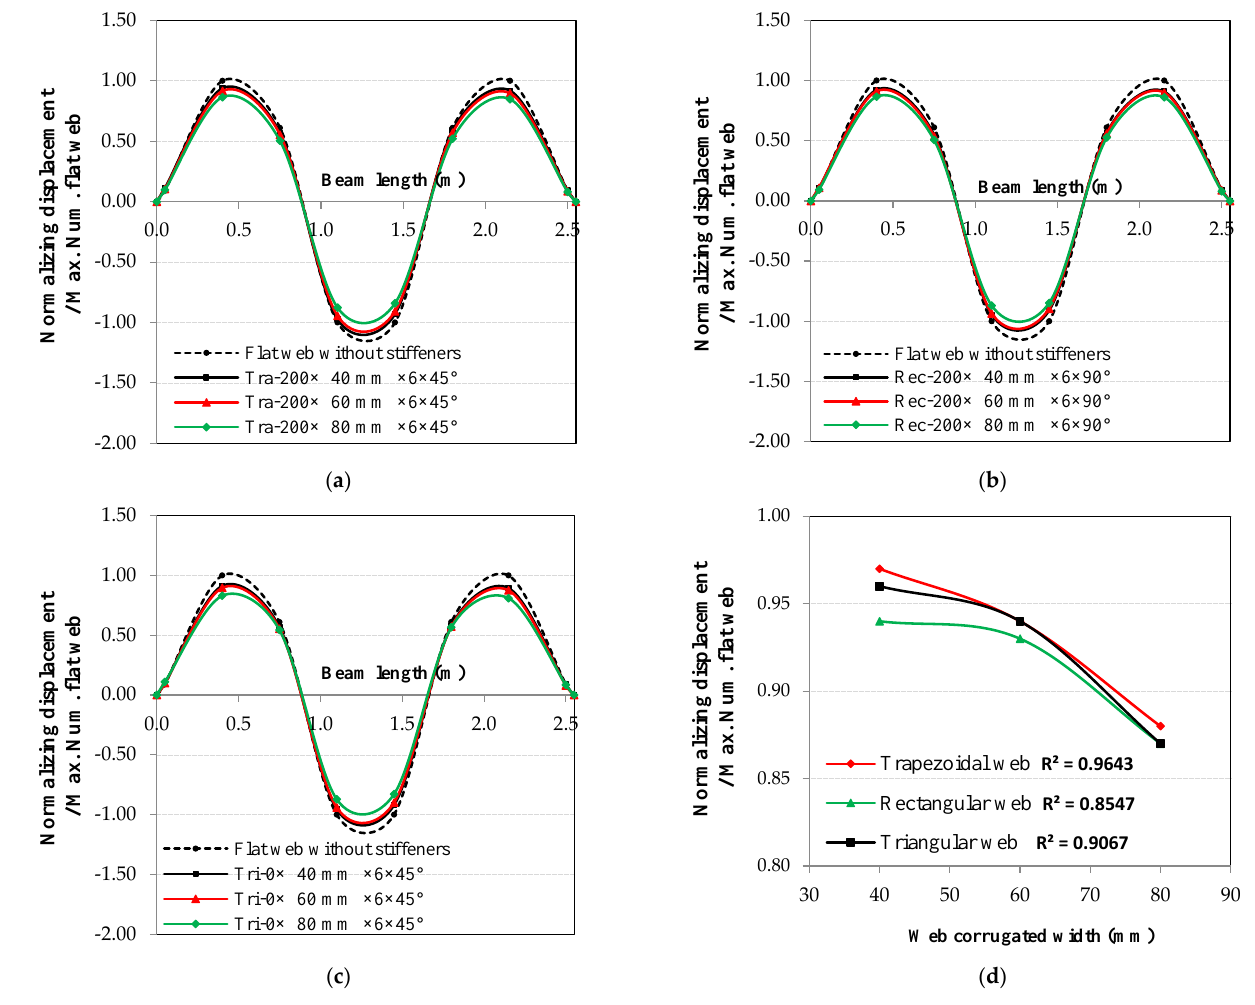
Figure 14. Corrugated width effect on the relationship between normalized displacement and beam length for the 3rd mode shape: ( a ) trapezoidal web, ( b ) rectangular web, ( c ) triangular web, and ( d ) width effect at the 3rd mode shape.